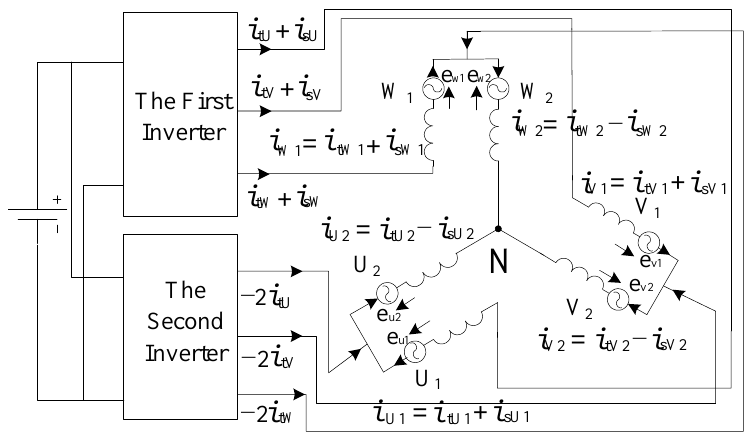
Figure 3. Winding topology of improved SBPMSM.